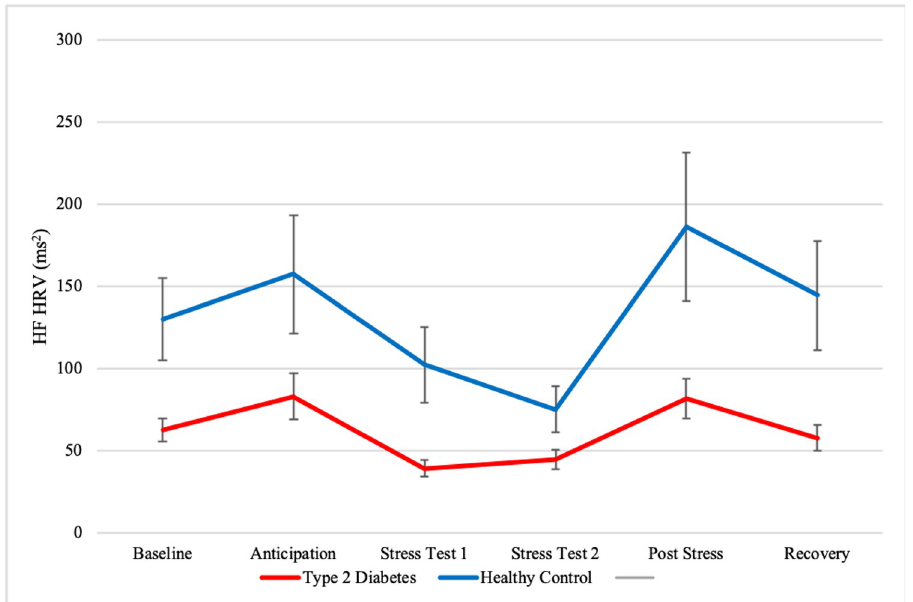
Fig 2. Mean HF HRV and standard errors of type 2 diabetes patients and healthy controls before and after stress induction. Note: Values depict averages of 3-minute HRV-samples. Time from baseline to anticipation was on average 27 minutes. The stress test took on average 14 minutes. Time from post-stress to recovery was approximately 15 minutes.